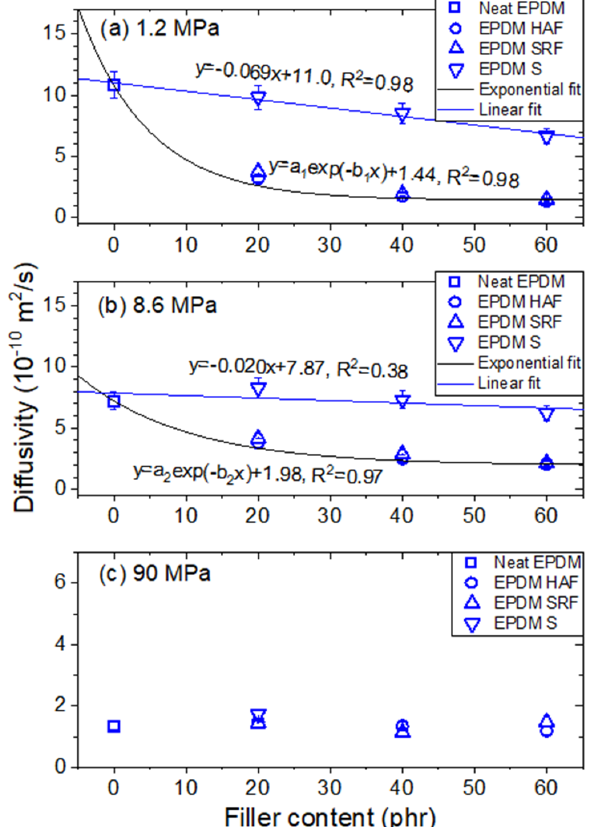
Figure 6. Diffusivity versus filler content for applied pressures of ( a ) 1.2 MPa, ( b ) 8.6 MPa, and ( c ) 90 MPa in peroxide ‐ crosslinked EPDM composites blended with CB and silica. The blue lines in ( a , b ) are the least squares fits for the negative linear relationship between the diffusivity and filler content with their squared correlation coefficient R 2 . The black lines in ( a , b ) are least ‐ squares fits with a single exponential decay relationship between the diffusivity and filler content with R 2 . However, with increasing pressures up to 90 MPa, the effect of filler on diffusion was reduced. Thus, the diffusivities for all specimens were almost constant and converged at approximately 1.5 × 10 − 10 m 2 /s. In the pressure region of bulk diffusion, the decrease in mean free path of H 2 molecules at 90 MPa could be a predominant factor in diffusivity behavior rather than filler content or filler species. 2.5. Correlations of Permeation with Physical/Mechanical Properties Figure 7a depicts the density variations versus filler content for twenty EPDM com ‐ posites crosslinked with sulfur and peroxide. The density increased linearly with increas ‐ ing filler content and exhibited a squared correlation coefficient R 2 = 0.94. Similarly, the linear correlation between hardness and density is represented in Figure 7b with R 2 = 0.90. Although divergence (R 2 = 0.76) with the data occurred, the linear correlation between tensile strength and density is also shown in Figure 7c. These three relationships indicated that their properties are linearly inter ‐ correlated with each other. From the three linear relationships, the physical and mechanical properties of EPDM composites crosslinked with sulfur and peroxide can be easily predicted from the contents of either CB or silica fillers.